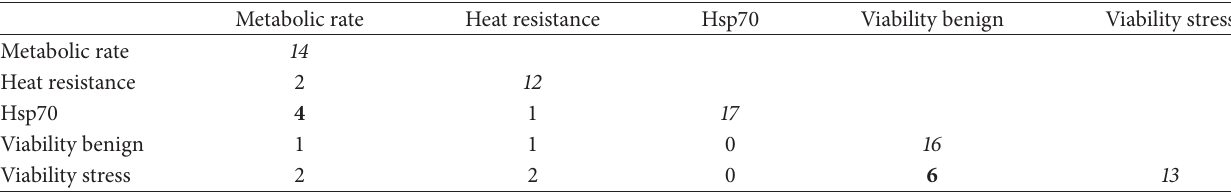
Table 3: Molecular function (a total of 239 GOs). Diagonal elements (italicized numbers) are the number of GOs with a 𝑝 < 0.05 . The off- diagonal elements show the number of elements shared between traits. Numbers in bold indicate a significant overlap. At a 𝑝 value of 0.05 one can expect 12 false-positive SNP-sets to be assigned as significant and one SNP-set assigned as overlapping.